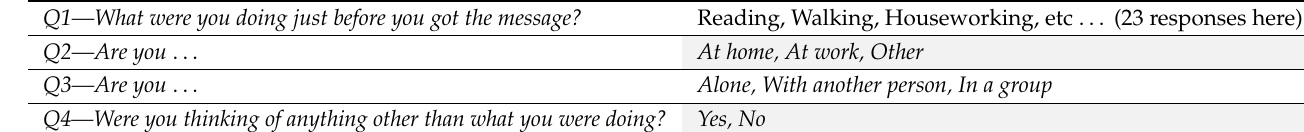
Table 2. Mind wandering’s probes: Survey questions and their responses and coding.